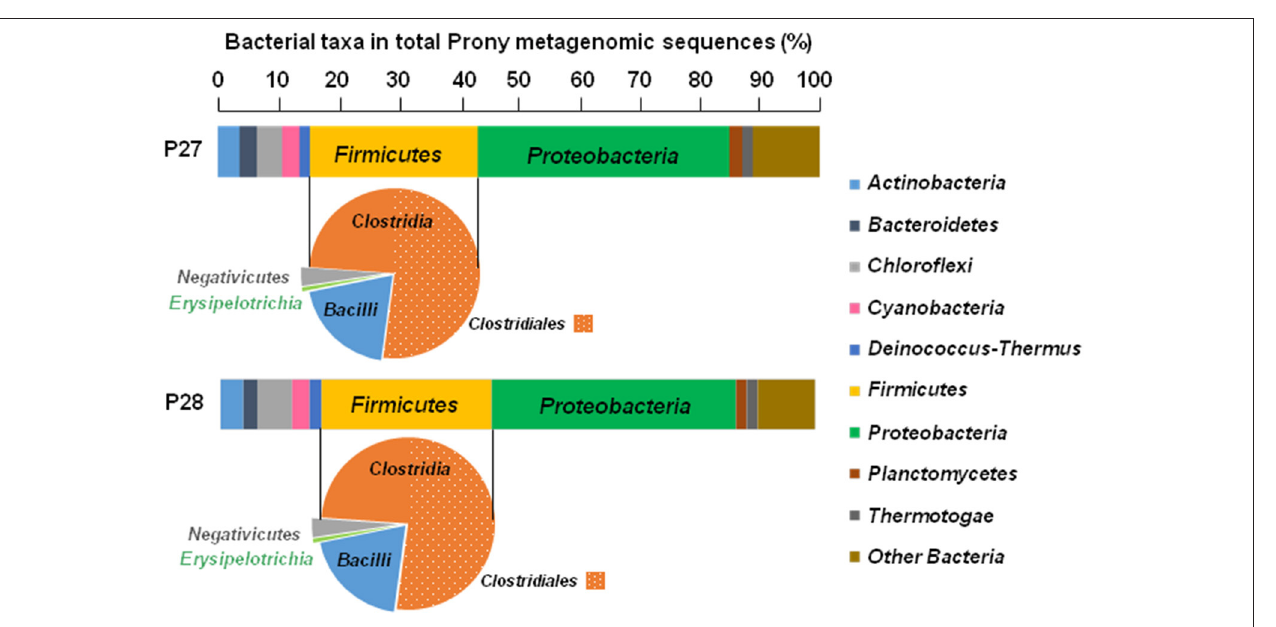
FIGURE 3 | Distribution and taxonomic assignments of total bacterial sequences in Prony Hydrothermal Field metagenomes P27 and P28 obtained from ST09 site. The histogram shows the relative abundance of major bacterial phyla in the total bacterial metagenomic sequences and pie charts show distributions of major Firmicutes